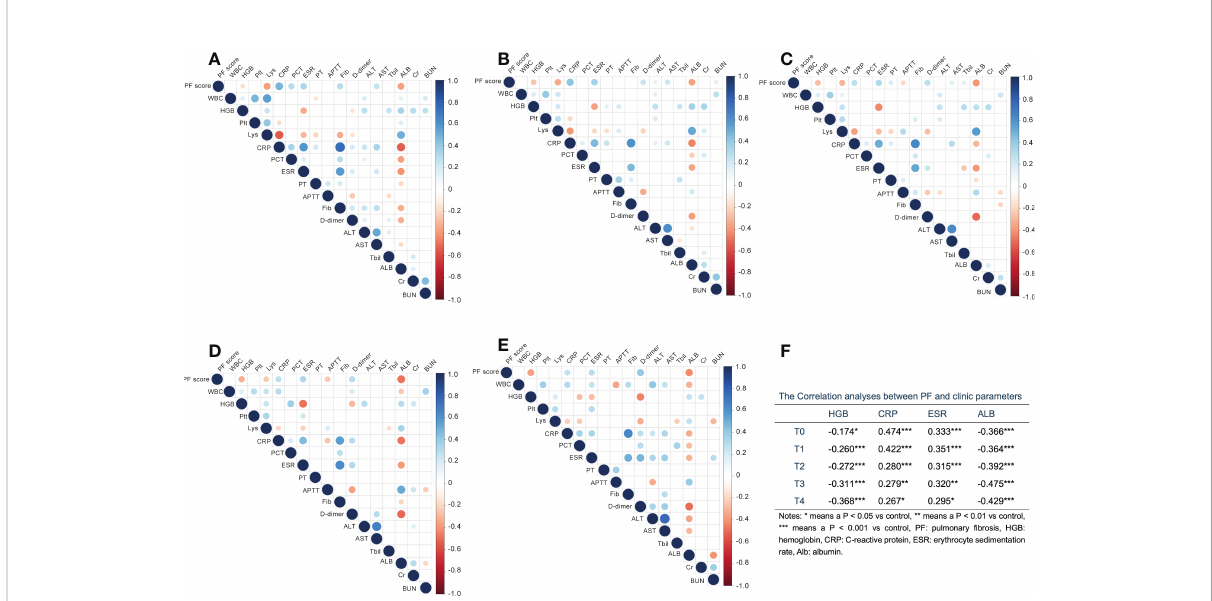
FIGURE 1 The correlation analysis between pulmonary fi brosis (PF) score and clinic parameters at different time points with fi rst 15 days after admission. (A – E) Digits represents Pearson correlation coef fi cients, fi lled color indicates signi fi cant correlation, blue represents positive correlation, red represents negative correlation, and shade of color represents strength of correlation. A for T0, B for T1, C for T2, D for T3, E for T4. (F) The correlation indexes for parameters which signi fi cantly associated with PF at all time points. WBC, white blood cell; HGB, hemoglobin; Plt, platelet; Lys, lymphocytes; CRP, C-reactive protein; PCT, procalcitonin; ESR, erythrocyte sedimentation rate; PT, prothrombin time; APTT, activated partial thromboplastin time; Fib, fi brinogen; ALT, alanine aminotranspherase; AST, aspartate aminotransferase; TBil, total bilirubin; Alb, albumin; Cr, serum creatinine; BUN, urea nitrogen. *p < 0.05, **p < 0.01, ***p <